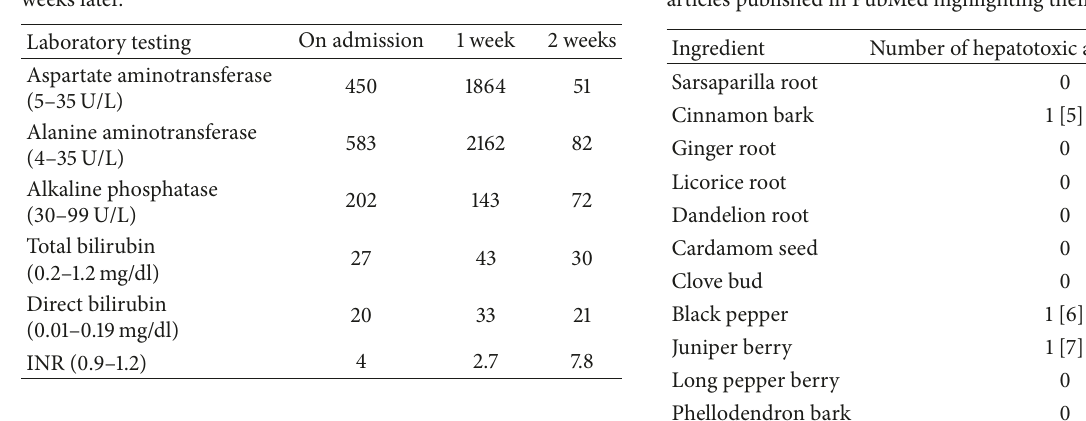
Table 1: Hepatic function panel on day of admission, 1 week and 2 weeks later.